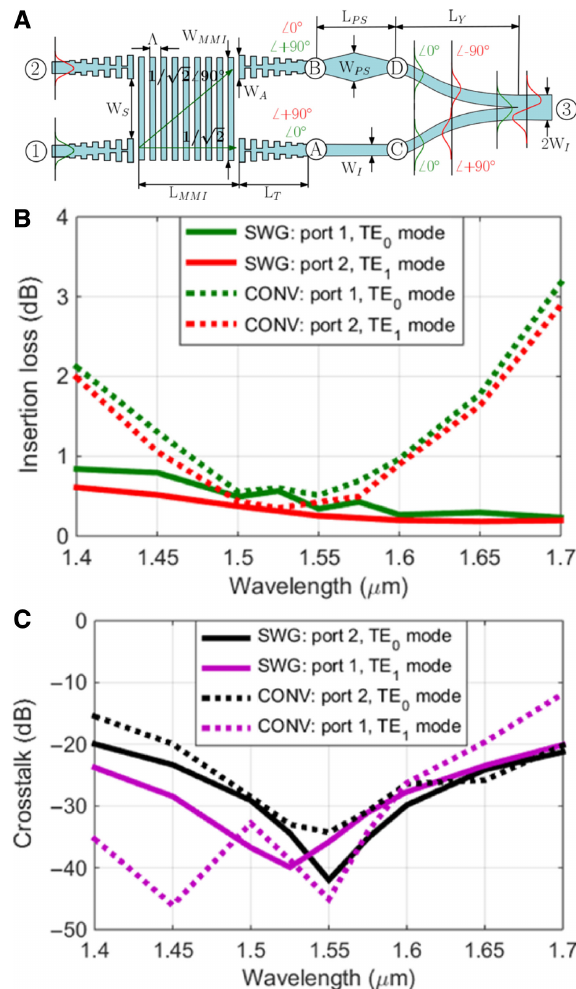
Figure 11: Theoretical study of an ultrabroadband mode multiplexer. (A) Schematic diagram of the mode multiplexer based on SWG MMI, a −90 ° phase shifter and a Y junction. Simulated device performance of the (B) IL and (C) CT as a function of wavelength. Reprinted from González-Andrade et al. [50]. Copyright © 2018 by the IEEE.